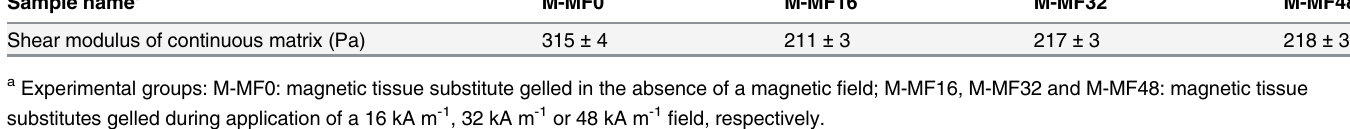
Table 3. Shear modulus of the continuous matrix of magnetic tissue substitutes, as calculated with Eq (3). Note the mean value of the shear modulus in control samples without particles (Ctrl-MF0 to Ctrl-MF48), G control = 101 ± 10 Pa. Uncertainties were estimated according to the theory of error propagation. Sample name a Shear modulus of continuous matrix